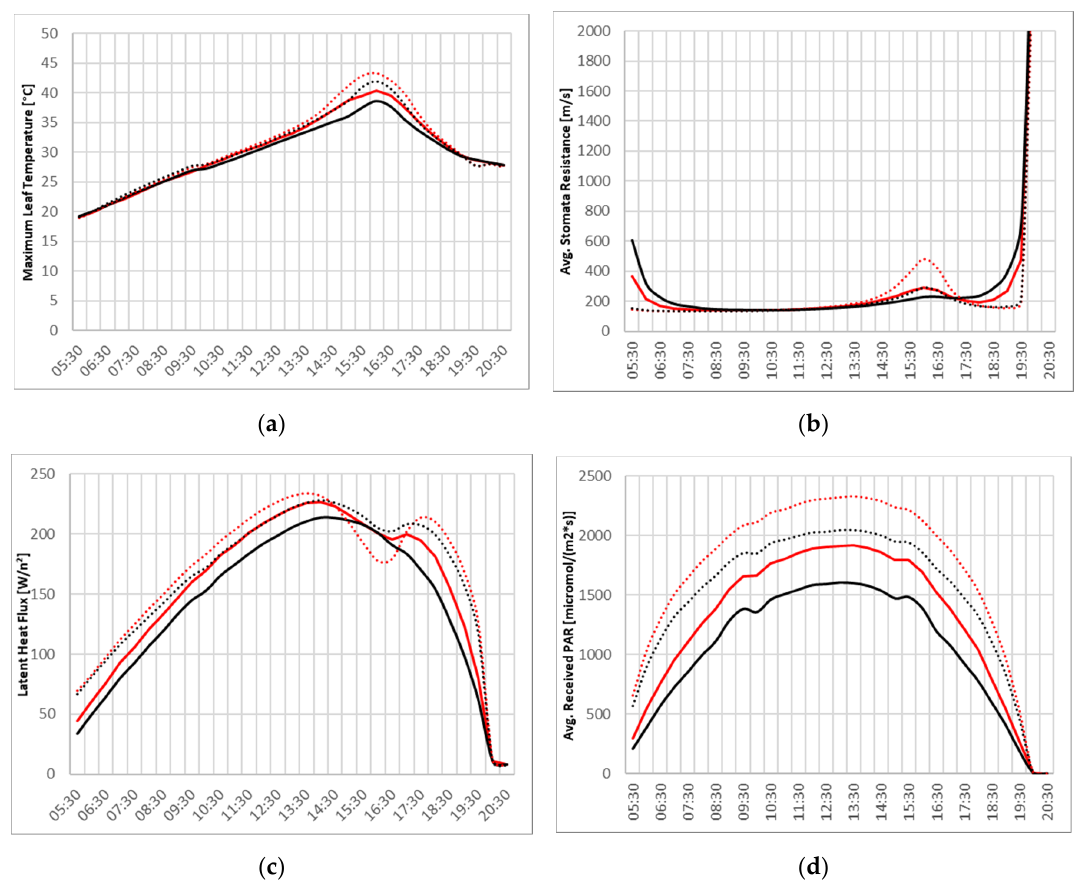
Figure 8. Graphs of various tree parameters: Maximum leaf temperature ( a ), average stomata resistance ( b ), latent heat flux ( c ), average received photosynthetic radiation ( d ). Red lines indicate L-Trees, black lines Parametric-Trees, dashed lines ACRT module off, solid lines ACRT on.